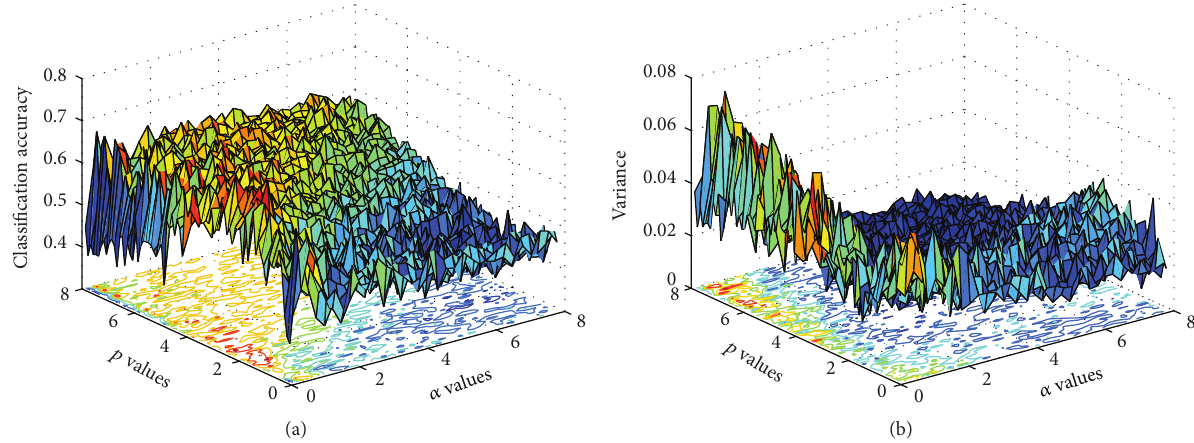
Figure 1: Mean classification accuracies (a) and the variances (b) obtained from the fertility data set with the Bonferroni mean based classifier, when 𝑞 = 6 .